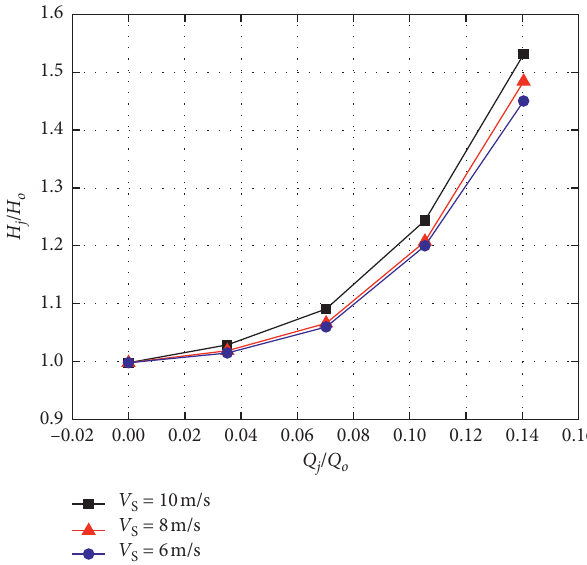
Figure 6: Relation diagram of head and jet flow.